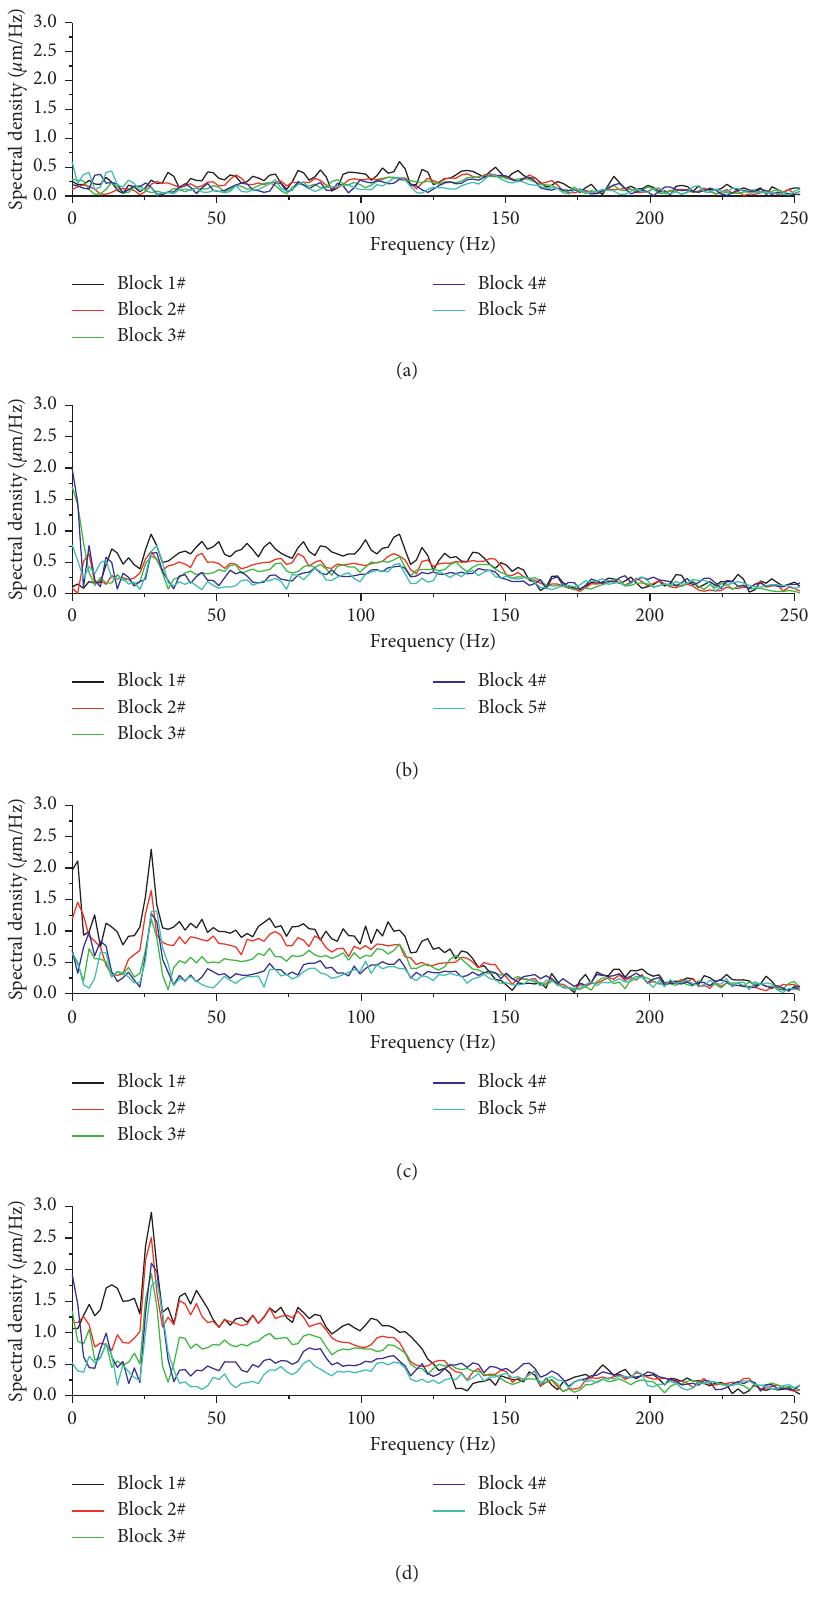
Figure 7: Spectral density of vertical displacement with different disturbance energies: (a) 50mJ; (b) 150mJ; (c) 250mJ; (d)